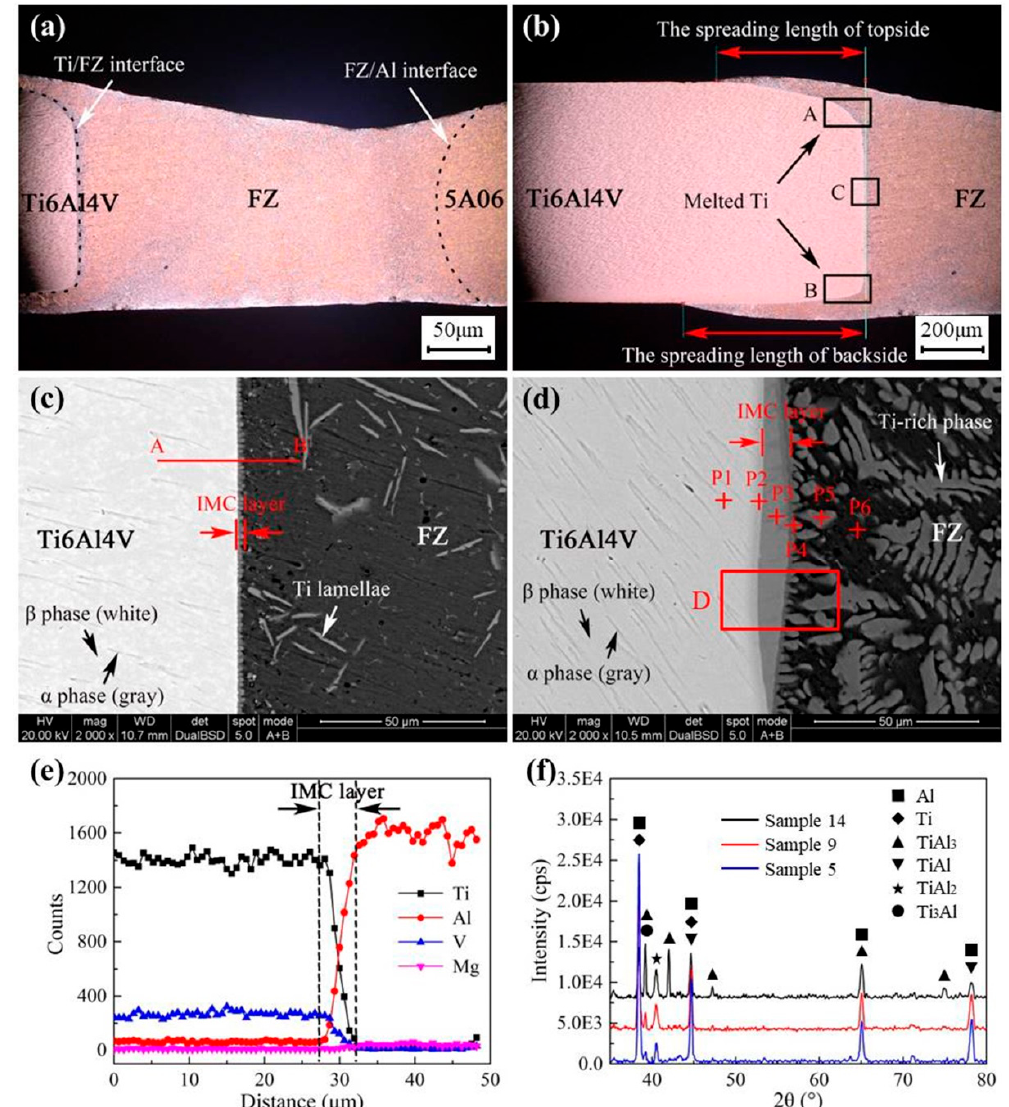
Figure 2. Cross section of the joint: ( a ) macro cross section; ( b ) local graph of cross section; ( c ) SEM image of the C region; ( d ) SEM image of the A region; ( e ) EDS line scanning along AB; ( f ) XRD scanning results of the D region in Figure 2d.